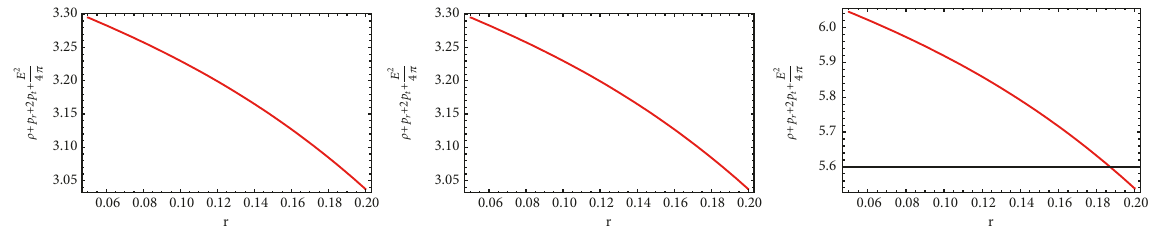
0.06 0.08 0.10 0.12 0.14 0.16 0.18 Figure 14: This figure represents the variation of 𝜌 + 𝑝 𝑟 + 2𝑝 𝑡 + 𝐸 2 /4𝜋 versus 𝑟 (km) for the strange star taking 𝛽 = 1 , 𝛽 = 2 , and 𝛽 = 3